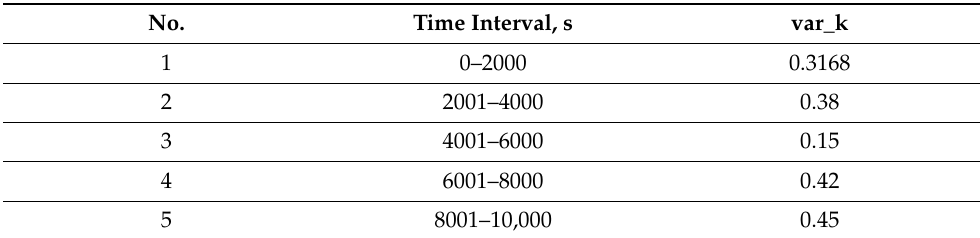
Figure 5. The control channel model in the Simulink environment. During the experiment, the variation of thevar_k coefficient was specified on several model time intervals, according to Table 1, at a constant control task value (the control task value remained unchanged within the entire simulation time). Table 1. Variation of the var_k coefficient on time intervals.